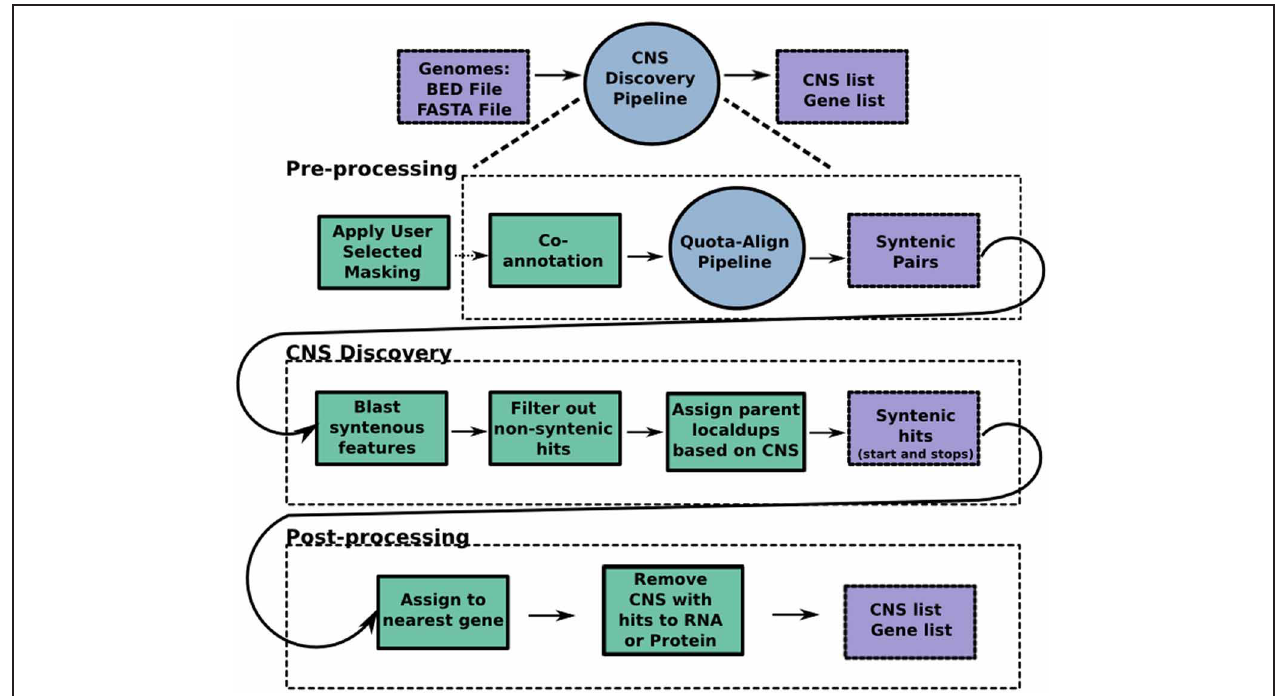
FIGURE 5 | The CNS Discovery Pipeline 3.0. The pipeline can be divided into three stages: pre-processing, CNS discovery, and post-processing. Co-annotation, where each genome helps find missed genes in the other, occurs during preprocessing, so any new genes found become available potential syntenic gene spaces for CNS discovery. Purple boxes represent input and output files while green boxes represent python scripts that make up each program. Each circle represents an individual program,